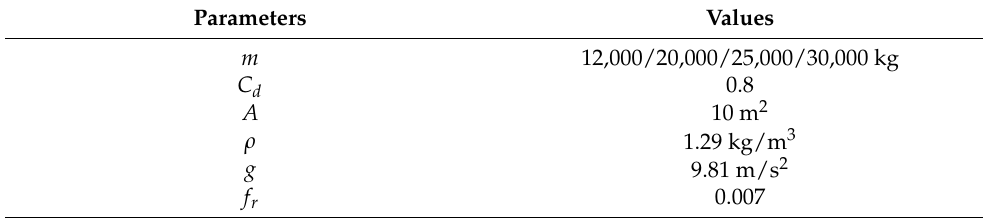
Table 2. Electric truck